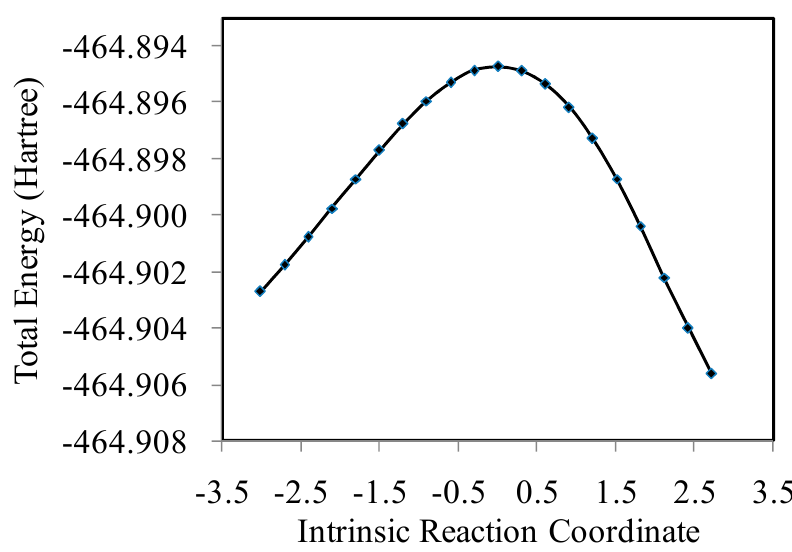
Figure 4. Intrinsic reaction coordinate calculation results.